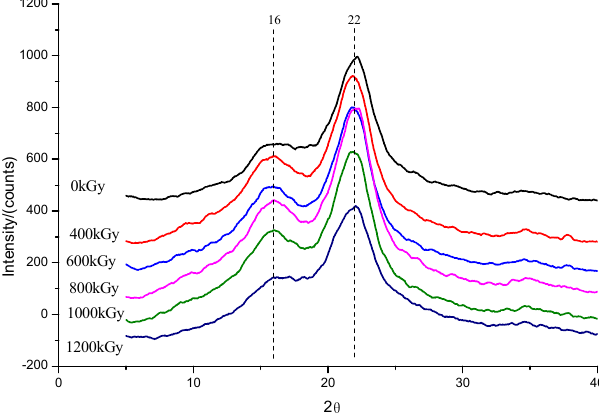
Figure 3. XRD patterns of the Miscanthus biomass irradiated with different doses.